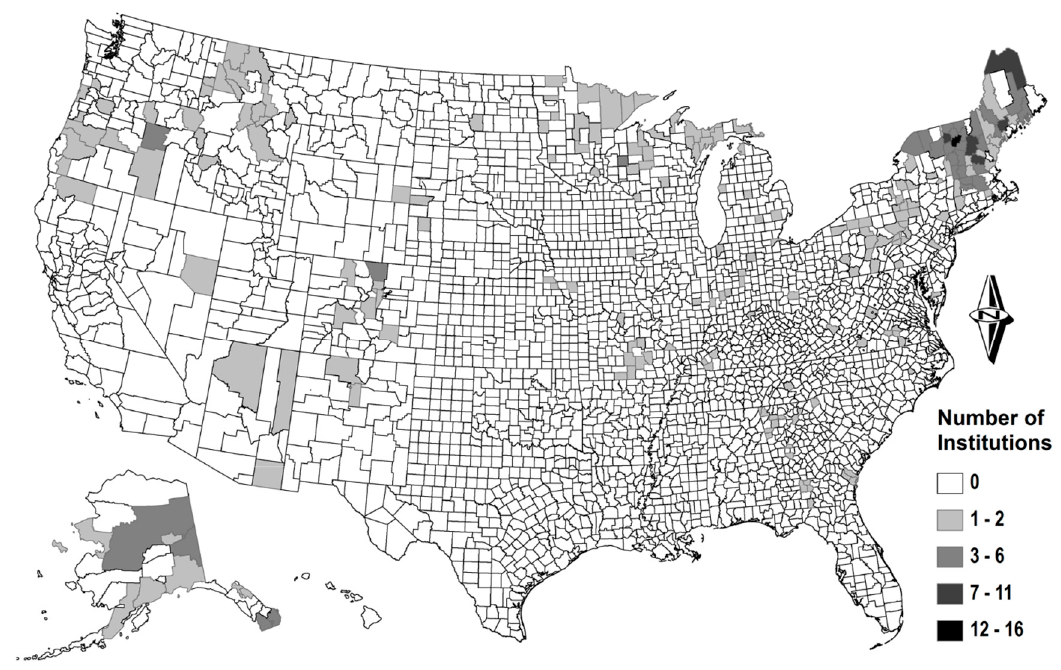
Figure 1. Number of institutions in each county using distributed-scale biomass heating in 2014, according to the Wood2Energy (W2E) database [1].